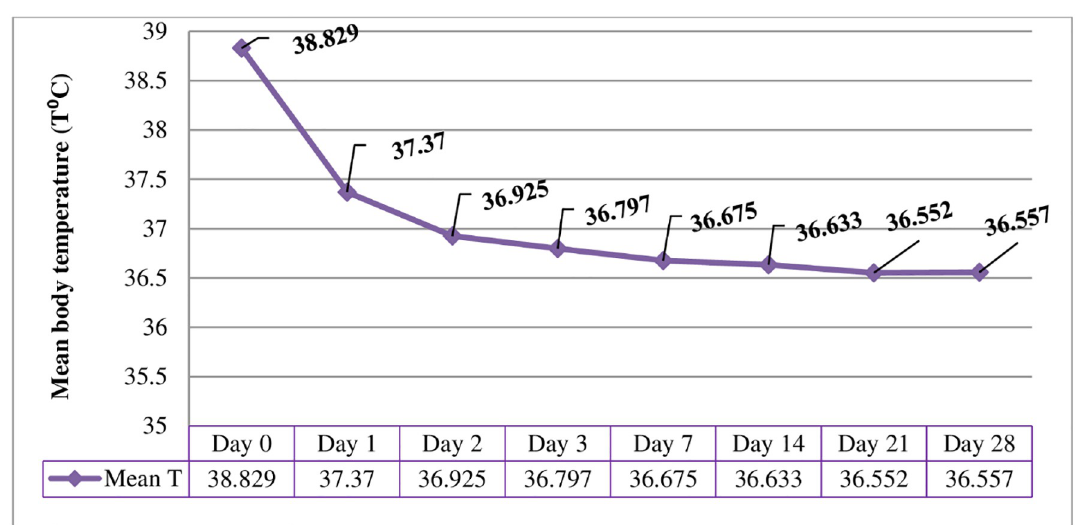
Fig 5. Mean axillary temperature on days zero to 28 among chloroquine treated P . vivax infected participants in Shewa Robit Health Center, northeast Ethiopia from November 2020 to March 2021.